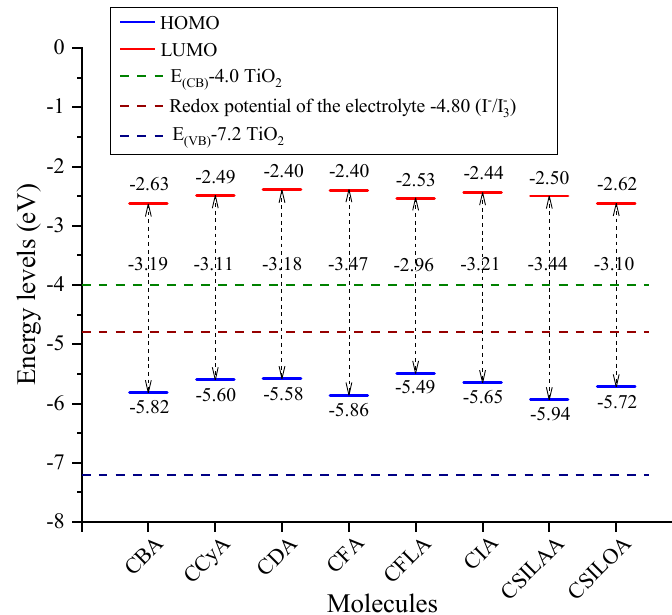
Figure 2. Highest occupied molecular orbital (HOMO) and lowest unoccupied molecular orbital (LUMO) energy levels of carbazole-based dyes calculatedwith the M06/6-31G(d) level of theory. The HOMO and LUMO energy levels are key elements to predict intermolecular charge transfer.